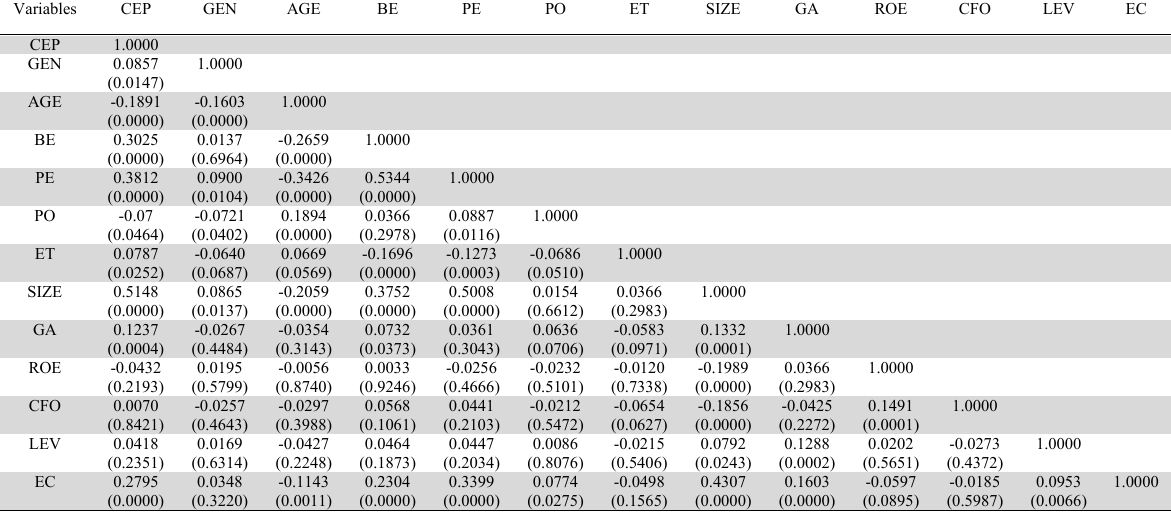
Correlation statistics for variable Variables